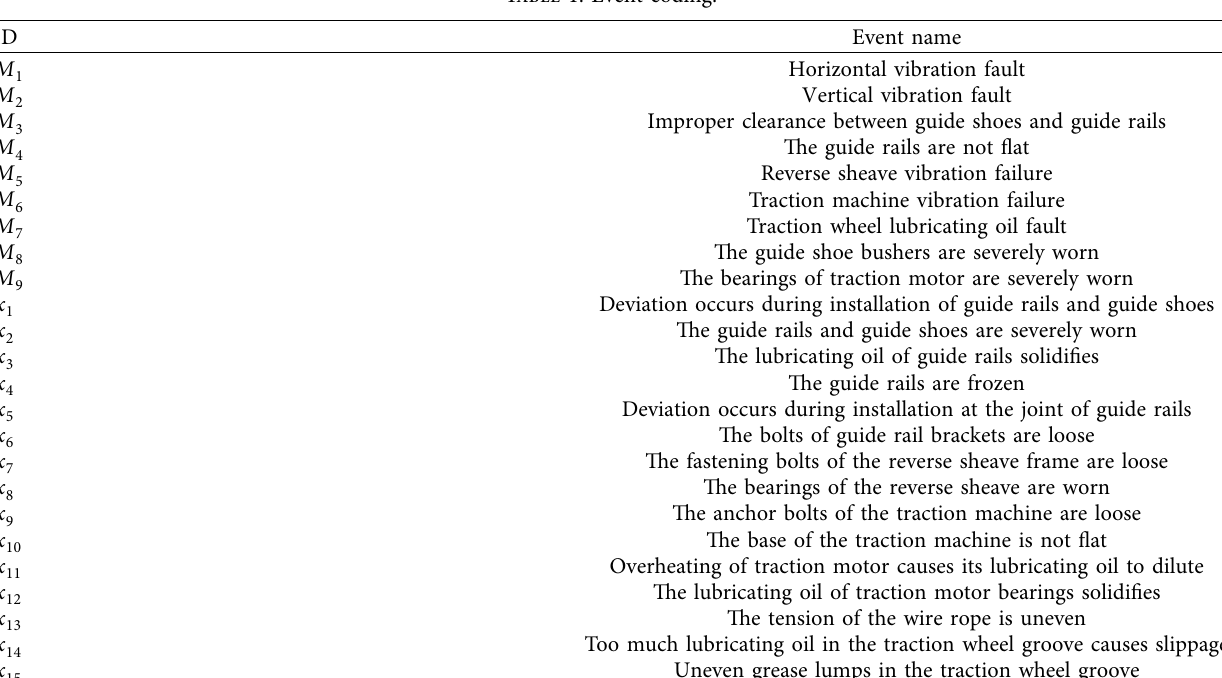
Figure 1: The elevator vibration fault tree. Table 1: Event